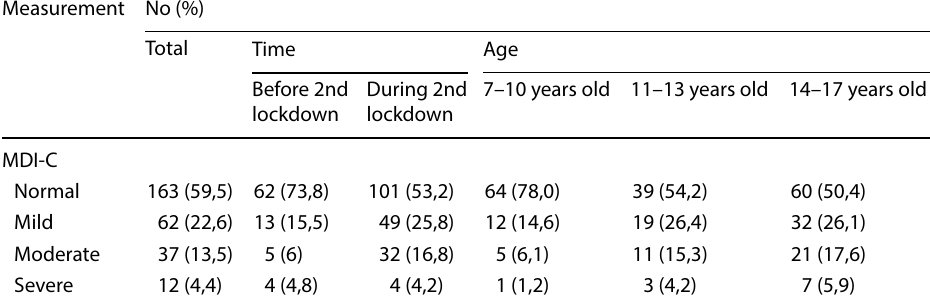
Table 2 Severity Categories of Emotional Distress Measures for Children by Groups ( N = 274)